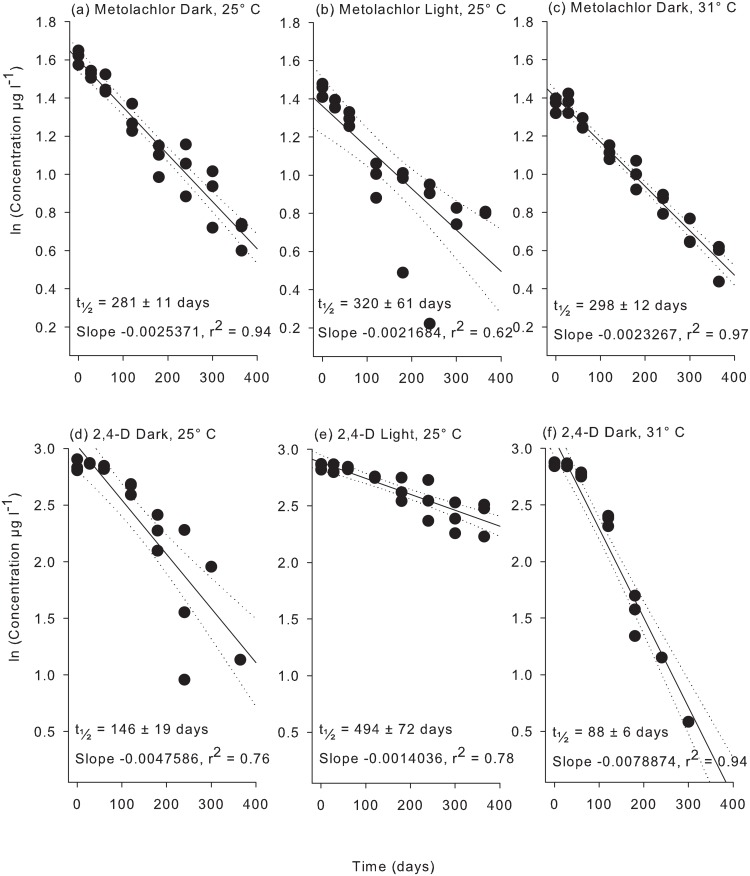
Experiment 2 half-life results for metolachlor and 2,4-D.ln(x) concentration of individual herbicide treatments: (a) metolachlor dark 25°C, (b) metolachlor light 25°C, (c) metolachlor dark 31°C, (d) 2,4-D dark 25°C, (e) 2,4-D light 25°C, and (f) 2,4-D dark 31°C over 365 days. Dashed lines represent 95% confidence intervals. Half-life reported ± SE.